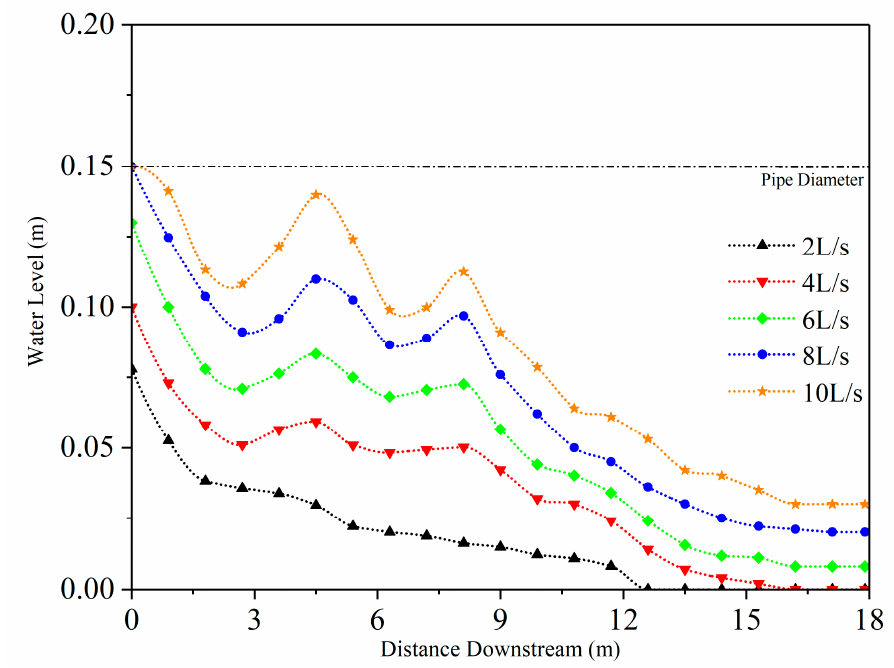
Figure 13. Water profiles for various inflow rates.